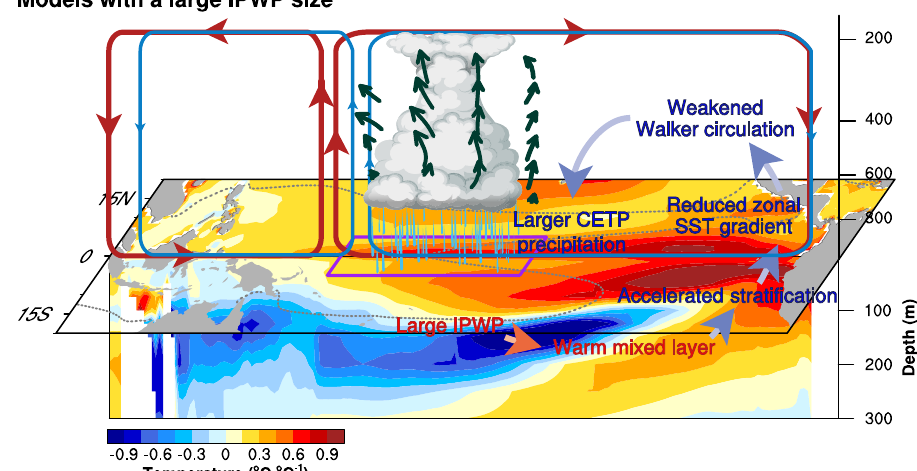
Fig. 5 Schematic diagram showing that the present-day Indo-Paci fi c Warm Pool (IPWP) constrains future tropical precipitation. Shadings indicate future changes in sea surface temperature (SST) in the Northern Hemisphere and ocean temperature along the equatorial Paci fi c in the longitude-depth plane (averaged between 5°N – 5°S) in climate models with a large IPWP size in the present-day. Vectors illustrate vertical motion. The purple box shows Central-Eastern Tropical Paci fi c (CETP) region and gray dashed lines represent the IPWP boundary in the present-day. Red text/arrows indicate the present climate, while blue text/arrows indicate changes in the